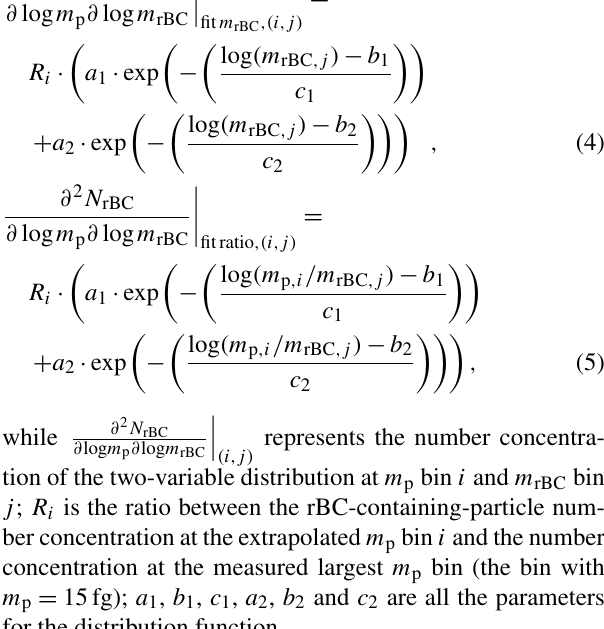
Figure 4 shows the two-dimensional distribution ∂ 2 N rBC graph which presents the measured BC ∂ log m p ∂ log m rBC mixing state. To improve the signal-to-noise ratio of the data, the measured CPMA–SP2 data have been averaged over 3 h periods. According to the measurement results from winter campaign period, three types of mixing state